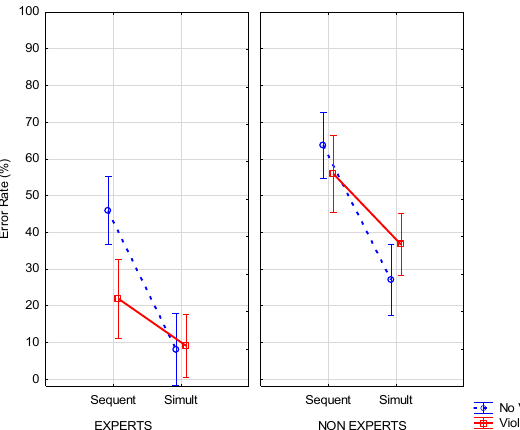
Figure 7. First fixation duration (ms) according to expertise, note modification and presentation (error bars represent standard